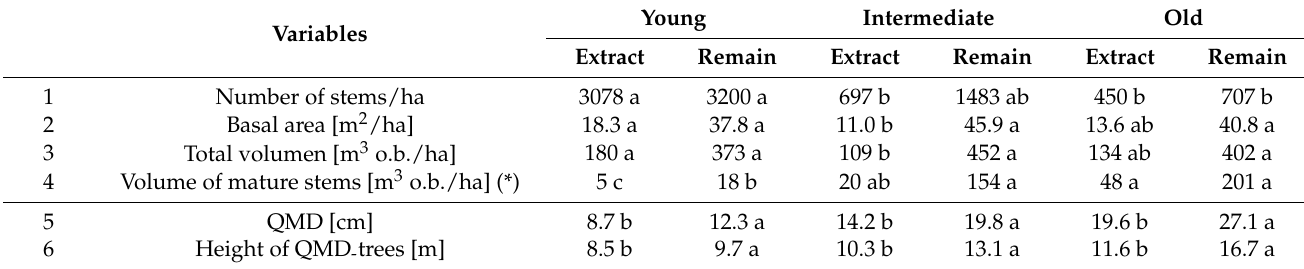
Table 5. Parameters of the trees to be extracted and to be alive in the simulation in every structure. The density variables (1–4) were compared between structures, while the size variables (5–6) within each structure (extract vs.